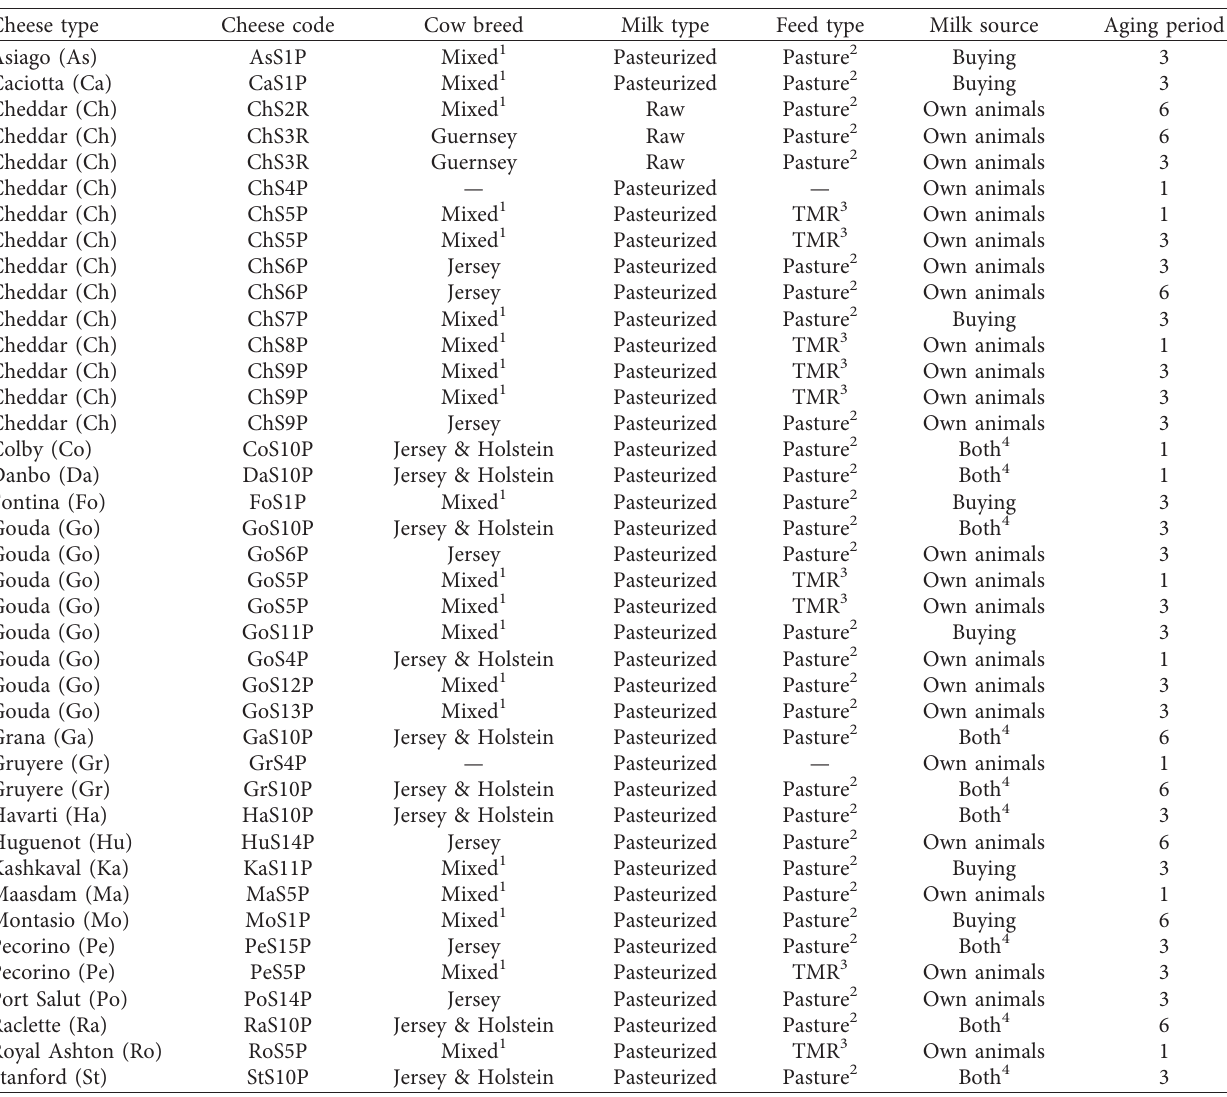
Table 3: Cheese samples from small-scale producers, classified per cheese type, cow breed, milk type, and aging period. Cheese